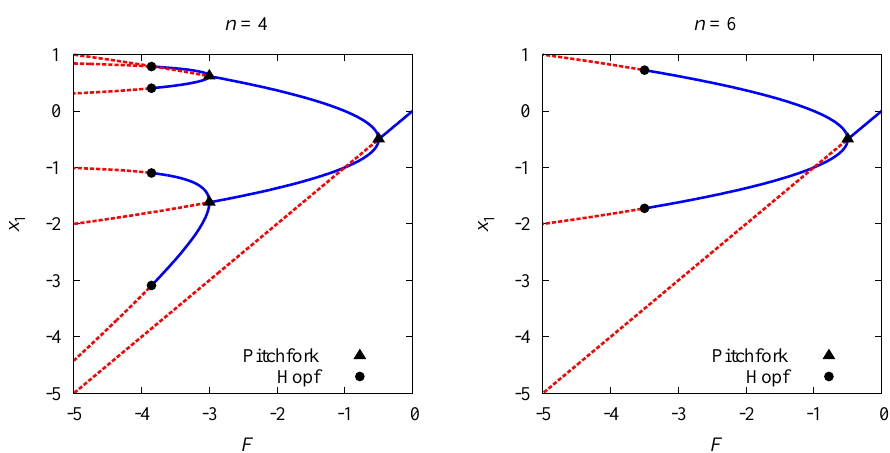
Figure 6. Bifurcation diagrams obtained by continuation of the equilibrium x F = (F,...,F) for F < 0 for the dimensions n = 4 and n = 6. Stable (unstable) branches are marked by solid (dashed) lines. For n = 4 two pitchforks in a row occur before the Hopf bifurcation, whereas for n = 6 only one pitchfork occurs before the Hopf bifurcation. The bifurcation diagram for n = 4 k with k ∈ N (resp. n = 4 k + 2) is qualitatively similar to the bifurcation diagram for n = 4 (resp. n = 6; see the main text).